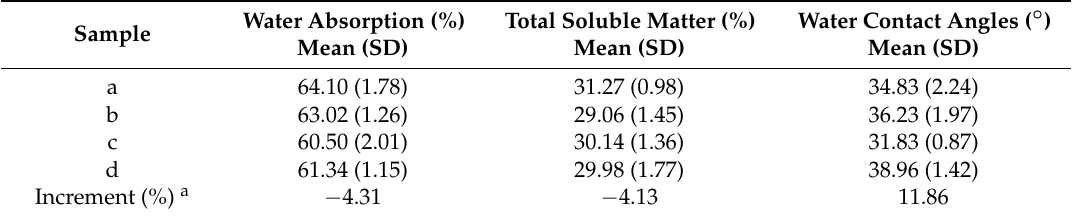
Table 4. Water Absorption (WA), Total Soluble Matter (TSM), and Water Contact Angles (WCA) of the SPI-based films